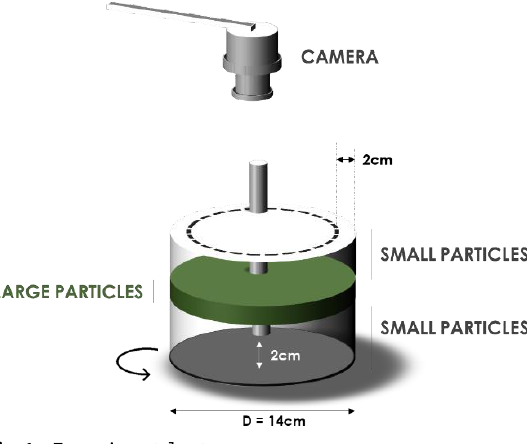
Fig. 1 : Experimental